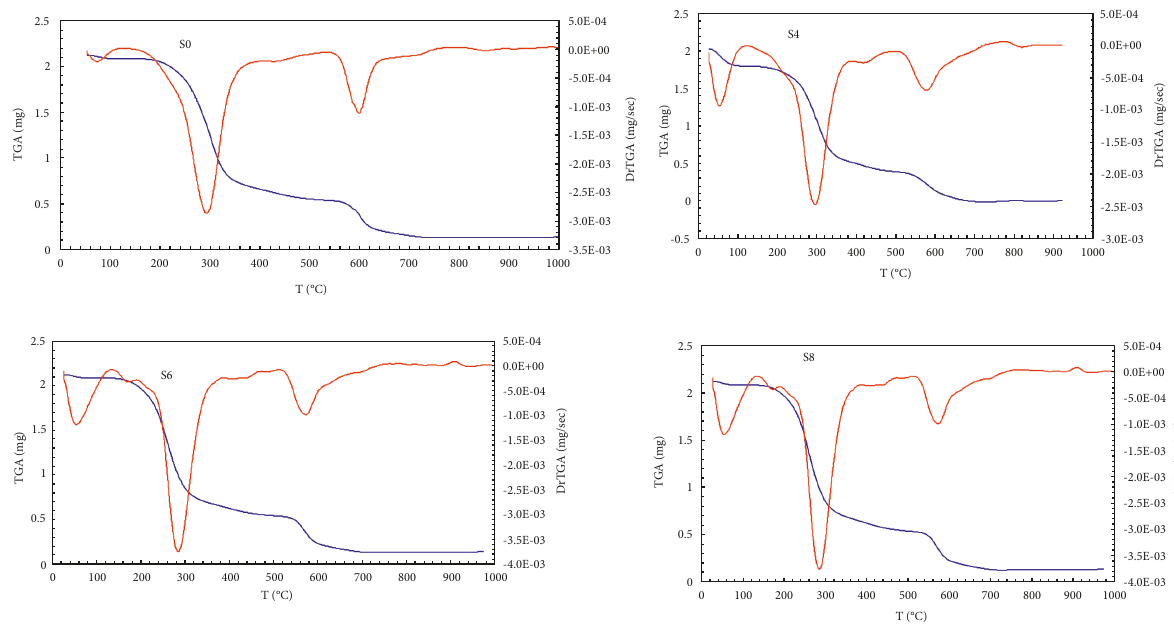
Figure 5: TGA and DrTGA curves of CuONPs-doped HEC samples. Table 2: TG and DrTG data for CuONPs-doped HEC samples. Region Sample